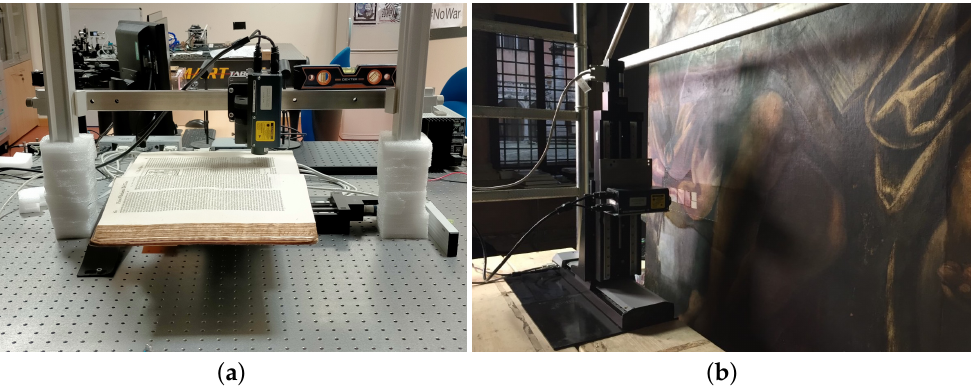
Figure 2. Microprofilometer applications on genuine case studies. ( a ) Laboratory configuration: microprofilometer on the optical table while scanning an ancient book. ( b ) In situ configuration: microprofilometer scanning an ancient large canvas painting by Tintoretto in the Church of the Frari in Venice, further explored by the authors in [19].